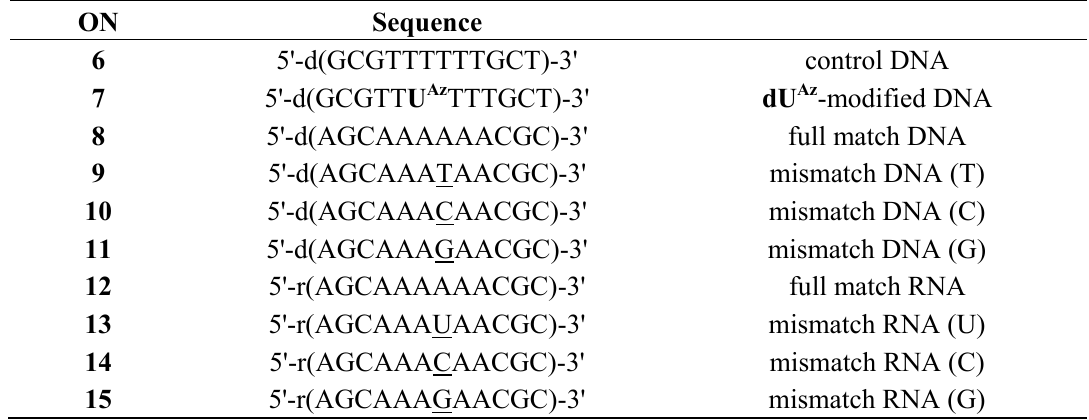
Table 1. The oligonucleotides used in this